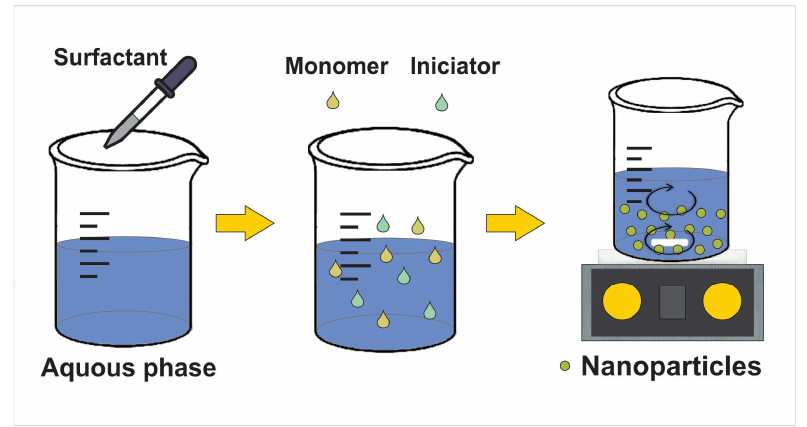
Figure 2. Preparation of nanoparticles by emulsion polymerization.